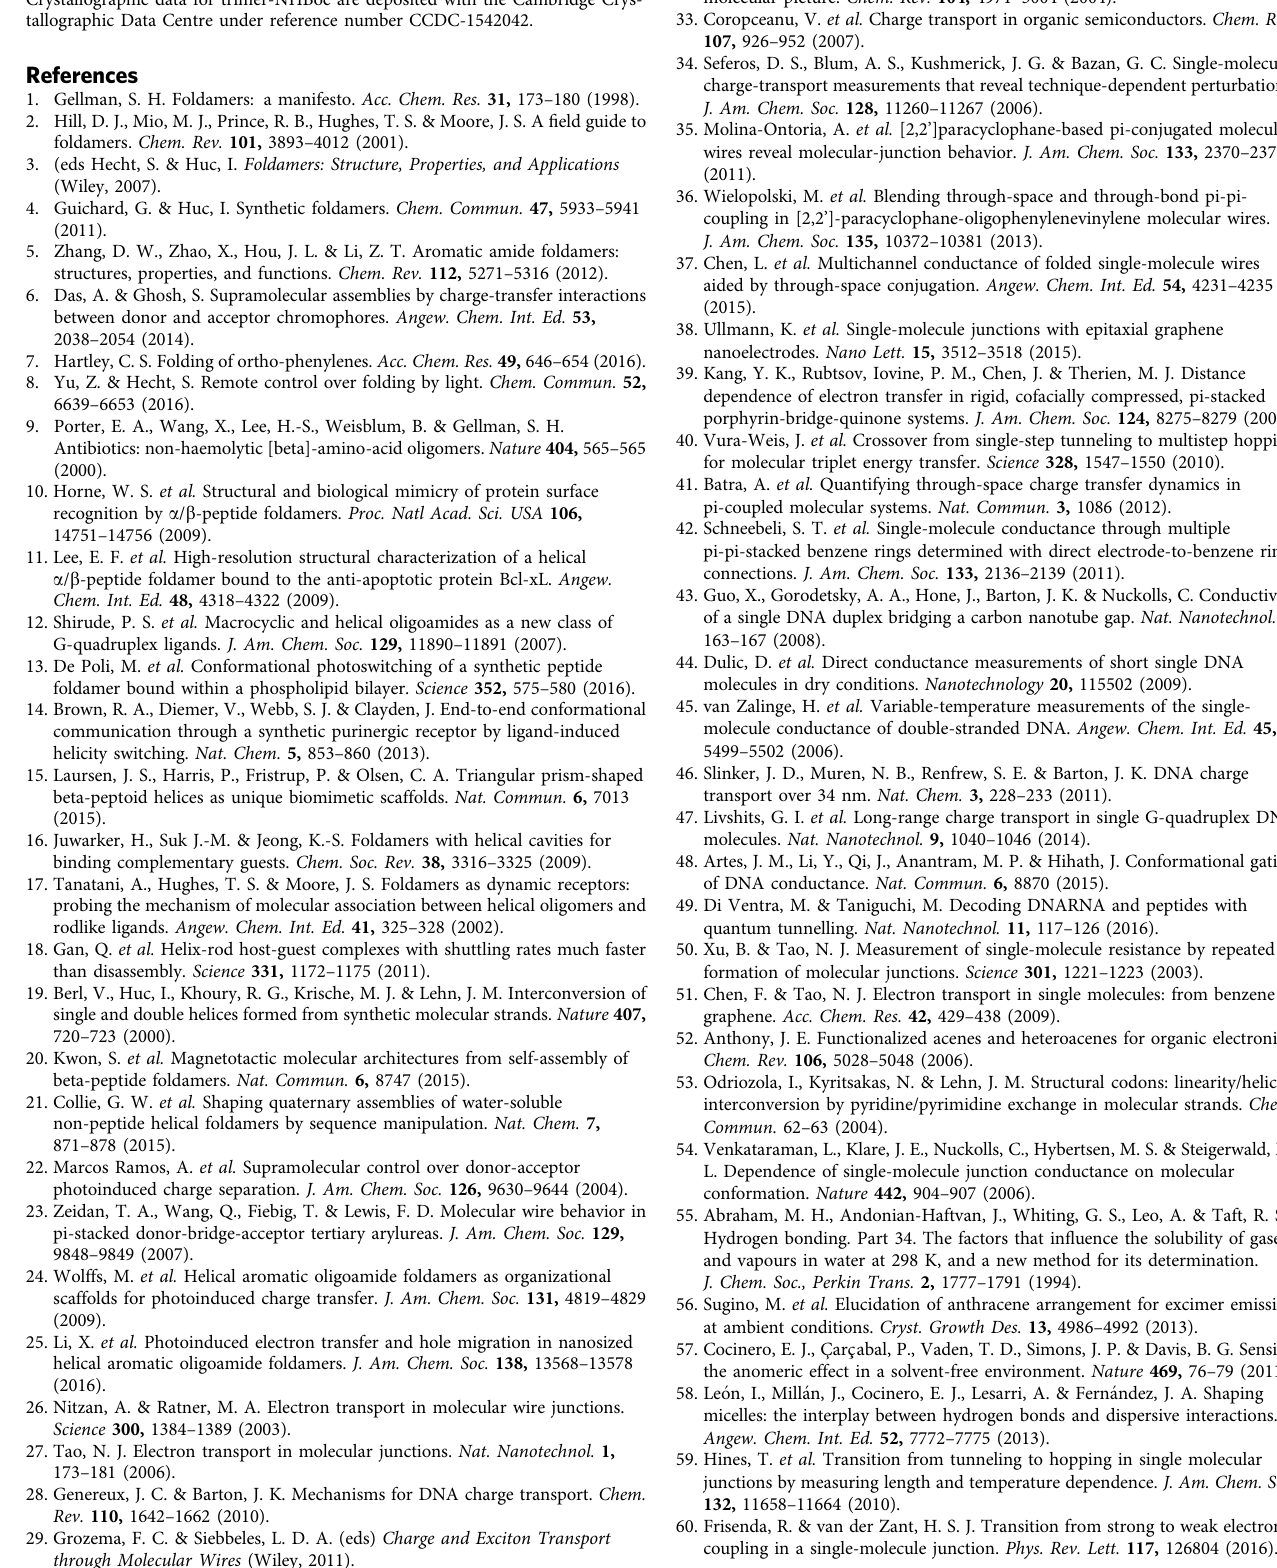
tallographic Data Centre under reference number